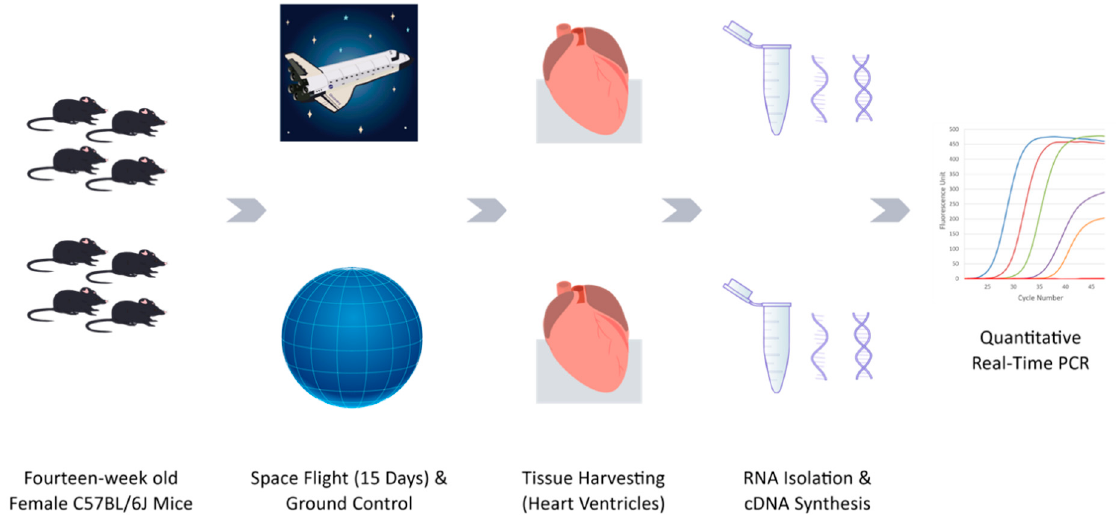
Figure 1. Schematic diagram of experiment design and workflow. Table 1. Spaceflight altered the expression of genes involved in oxidative stress pathway. Expression levels are represented as fold regulation in spaceflight versus ground controls (FLT versus GRD). Shown are 14 differentially regulated genes out of a panel of 84 genes related to the oxidative stress response as measured by RT-PCR. Of these, 11 were upregulated while three were downregulated. The change in expression levels of these genes were found to be statistically significant by Mann– Whitney U test at p < 0.05, n =